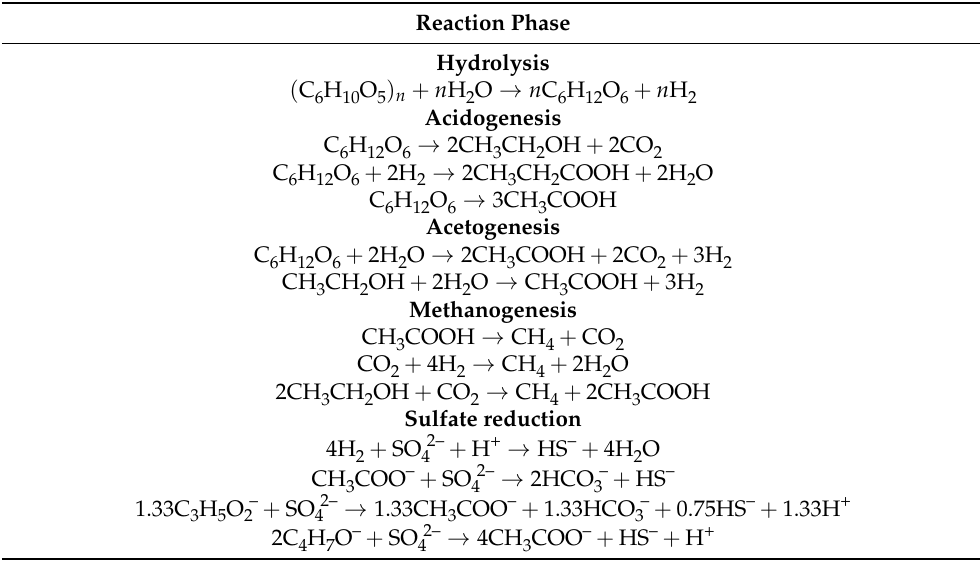
Table 1. List of reactions happening in the anaerobic